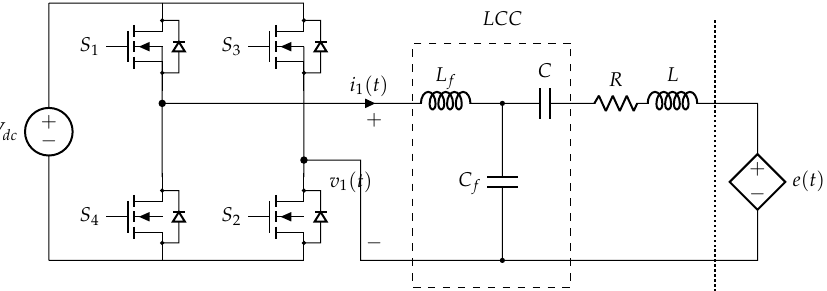
Figure 2. Transmitting coil equivalent circuit, composed of an H-bridge inverter, LCC compensation network and winding model with a series controlled voltage source to represent the coupling with the receiver and adjacent